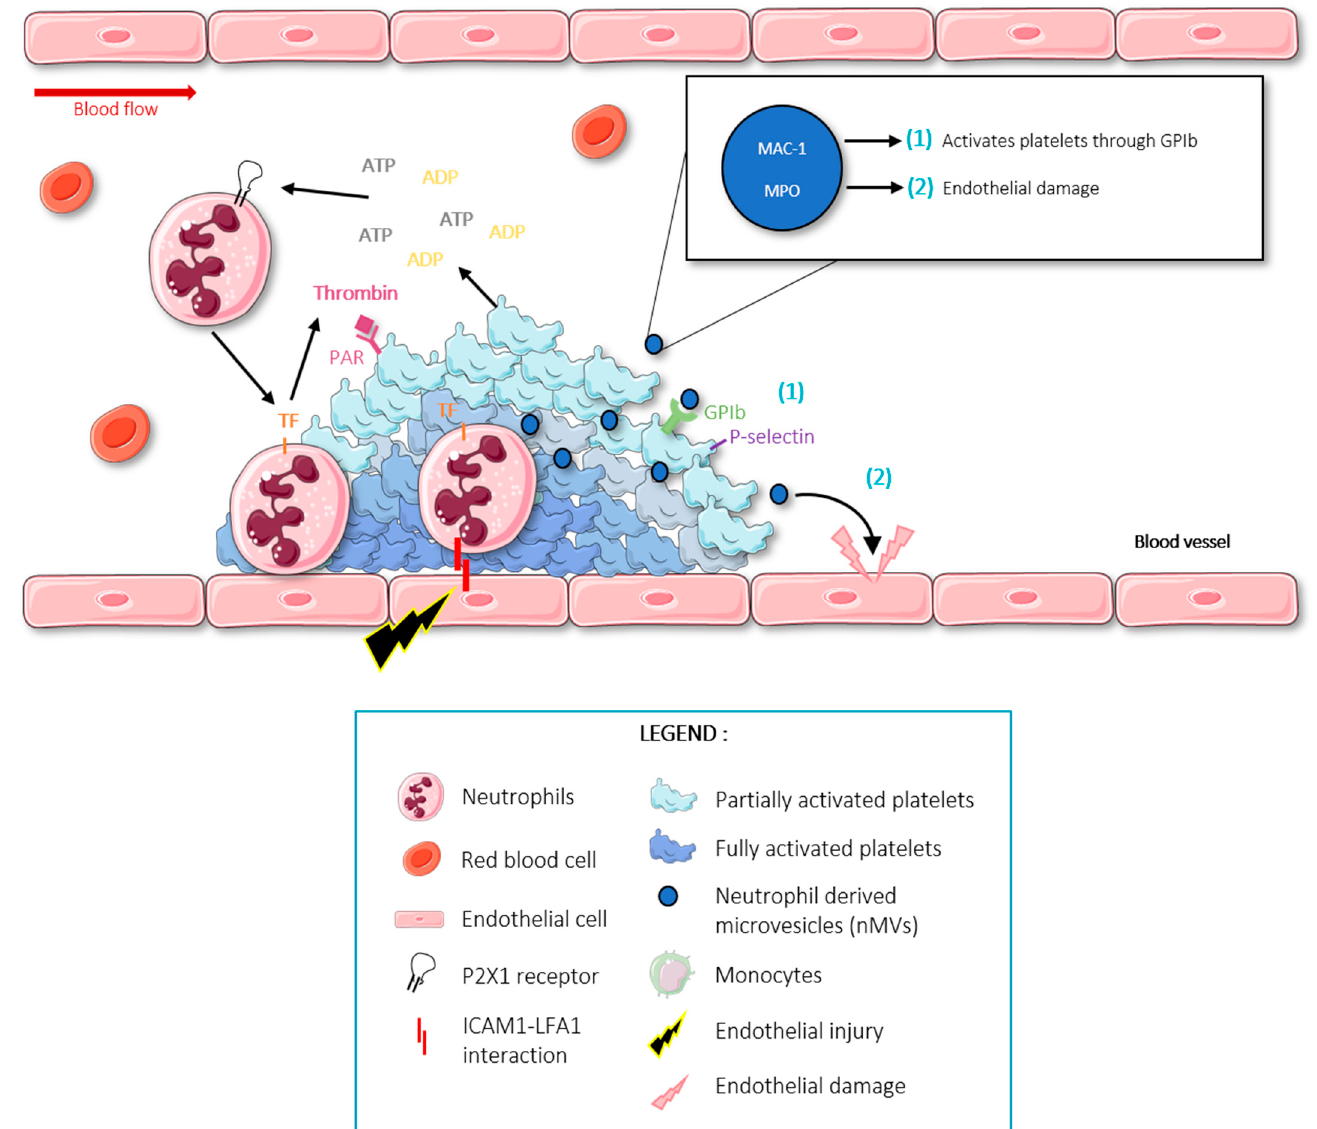
Figure 1. Schematic representation of neutrophil interactions and implications in thrombosis. Following endothelial injury, activated neutrophils express TF, which initiates the coagulation cascade resulting in thrombin generation and platelet activation. Activated platelets create a positive feedback loop to recruit more circulating platelets. Figure created using Servier Medical Art available at http://smart.servier.com/ (accessed on 15 September 2021).